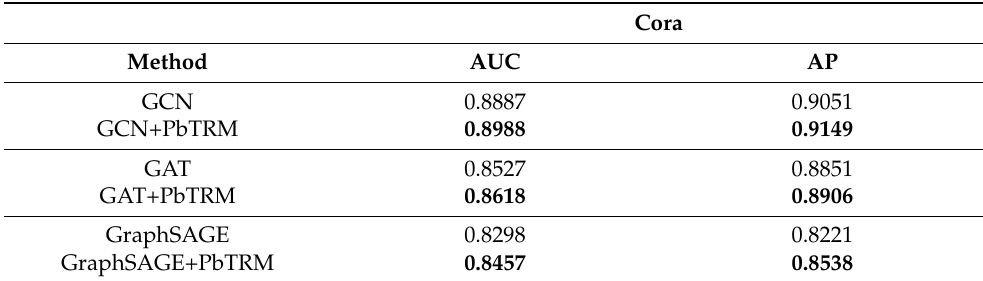
Table 2. The comparison of prediction performance between GNN+PbTRM and benchmarking GNN models on Cora.